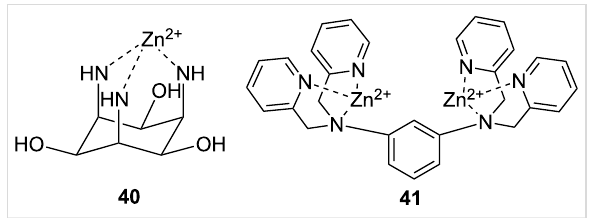
Figure 15: Metal ion complexes used in kinetic studies of medium effects on the cleavage of RNA model compounds.